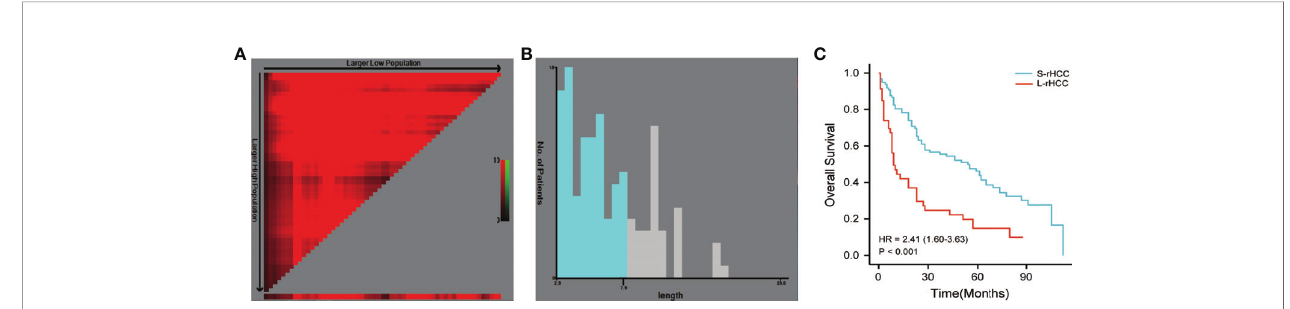
FIGURE 1 | The cutoff value determined by X-tile software was 7.9 cm (A, B) . The cutoff value of 8.0 cm was selected to divide patients into S-rHCC and L-rHCC groups. There was a signi fi cant difference in OS between the two groups [HR = 2.41 (1.60 – 3.63), P < 0.001] (C)